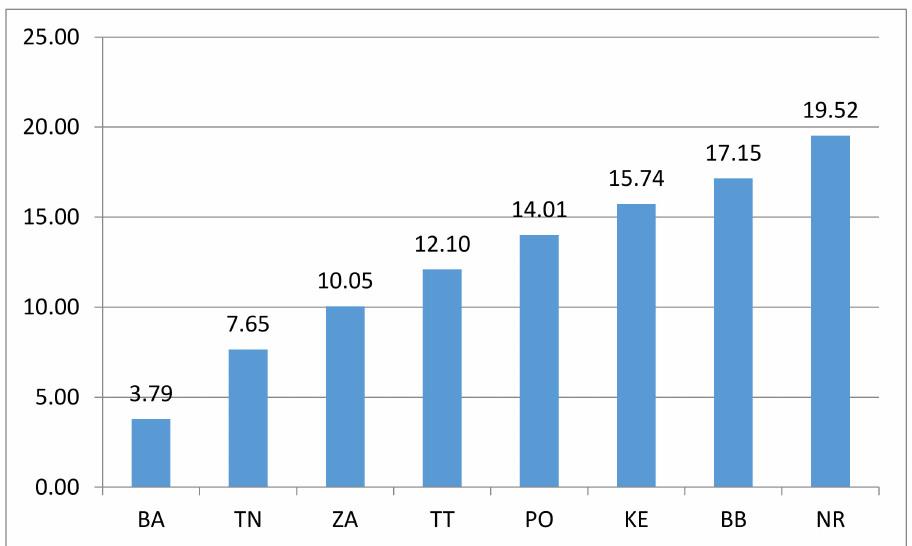
Figure 2. Share of agricultural land of particular regions (NUTS III) in total agricultural land in the SR in 2019 (%).Source: own calculations on the basis of data from Statistical Yearbook on Land Fund in the SR, 2019. (Explanation of remarks: the Bratislava region (BA), the Trnava region (TT), the Trenˇc í n region (TN), the Nitra region (NR), the Žilina region (ZA), the Bansk á Bystrica region (BB), the Prešov region (PO) and the Košice region